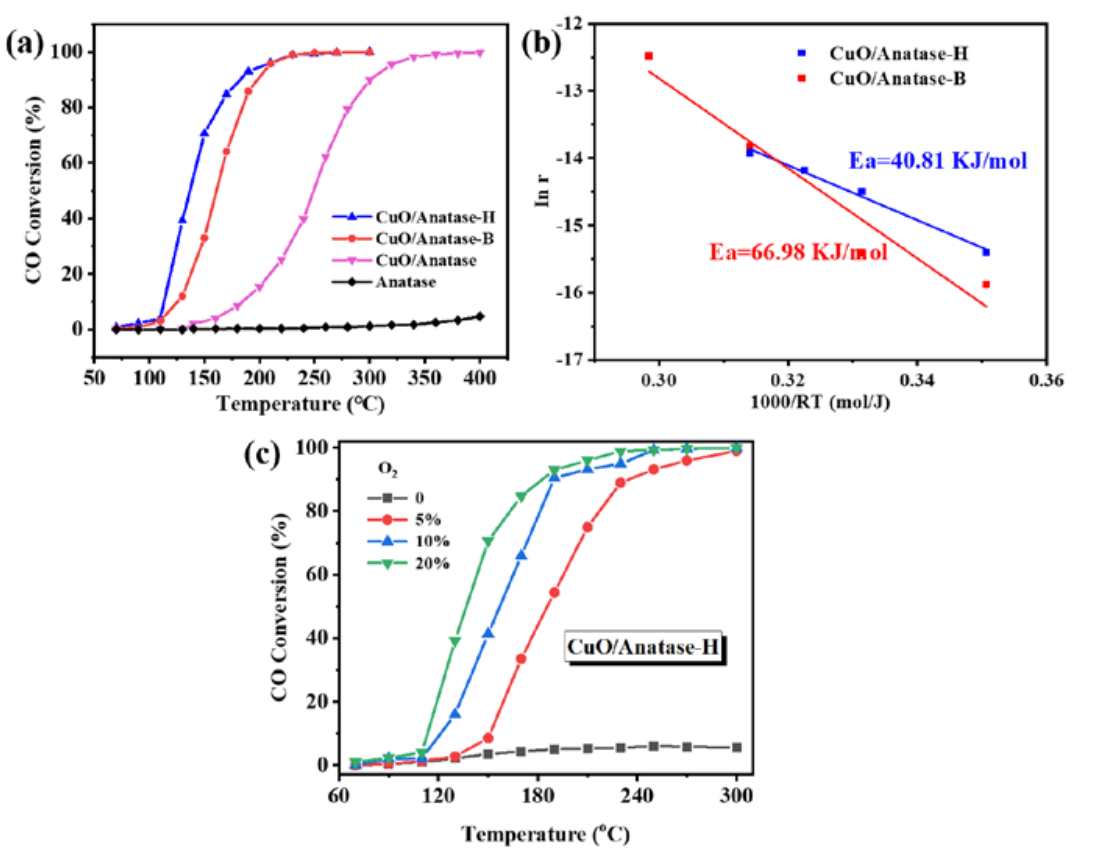
Figure 7. ( a ) Light − off curves for catalytic CO oxidation of anatase, CuO/anatase, CuO/anatase-B and CuO/anatase-H catalysts. ( b ) Apparent activation energies of CuO/anatase-B and CuO/anatase-H catalysts. ( c ) The CO conversion of CuO/anatase under different content of O 2 . Reaction conditions: 1% CO, 20% O 2 and balanced with N 2 , GHSV = 60,000 mL · g − 1 · h − 1 .